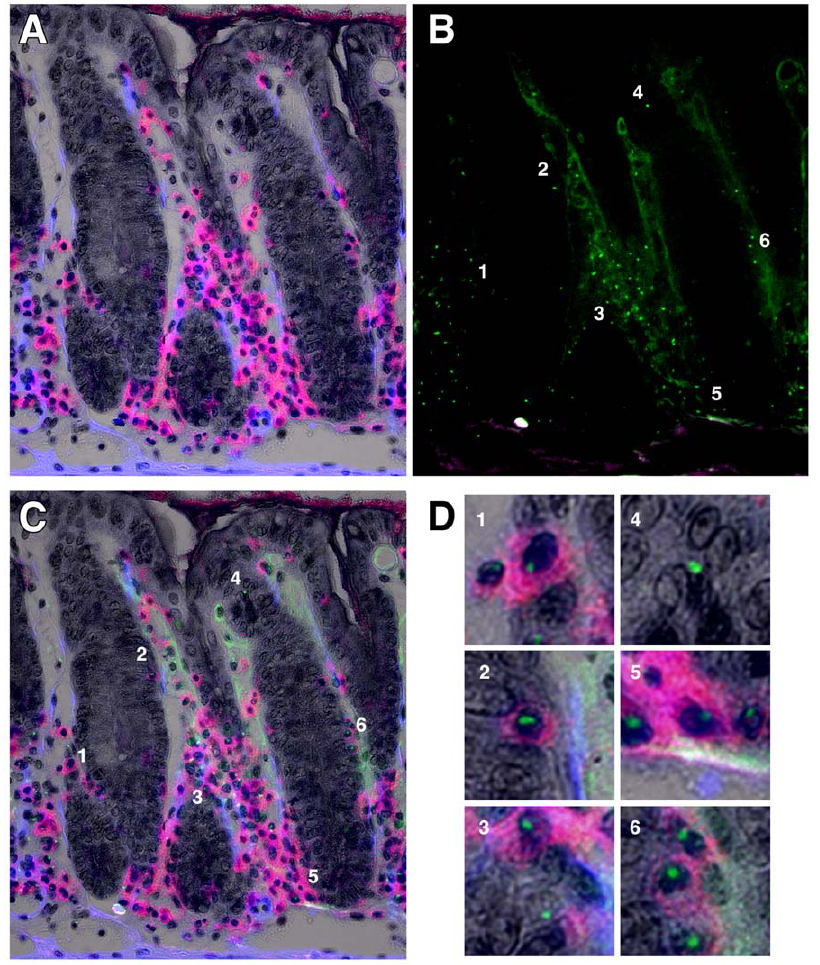
Figure 5. Triple IHC with Y chromosome analysis. A. Triple IHC for a -SMA (blue), CD45 (red) and Dolichos biflorus agglutinin (dark grey to black) in the colon of a female mouse with GvHD-like syndrome 28 days after male BMTx. Brightfield image (greyscale, nuclei counterstained with haematoxylin) overlain with fluorescent blue and red signals. B. Subsequent analysis of Y chromosome signals (green dots) on same section as A, showing some autofluorescence as pale green and purple. C. Overlay image of A and B, with cells of interest highlighted and shown in D Panels 1–6. Original magnifications A–C 200X. Panels in D are further digital magnifications of C to 1000X.